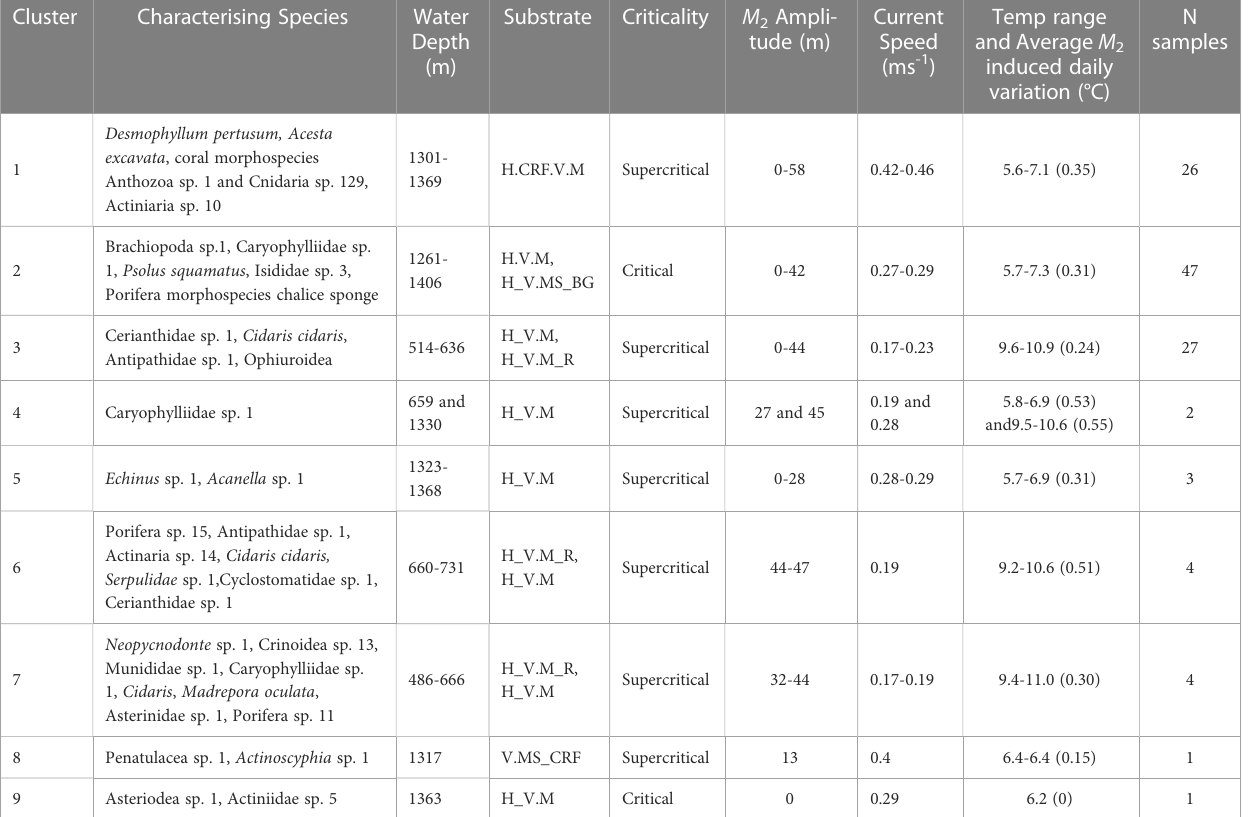
TABLE 5 Clusters identi fi ed from multivariate hierarchal clustering analysis with associated environmental parameters, number of samples represented by each cluster and SIMPER results identifying the morphospecies that characterise the clusters (70% accumulative contribution cut off). Cluster Characterising